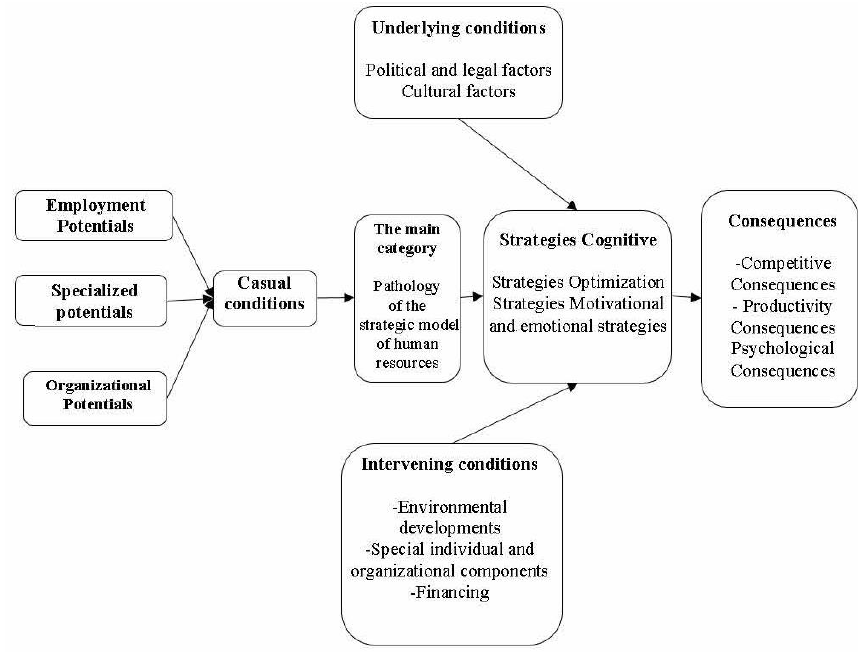
Figure 1- Proposed research model of Pathology of the strategic model of human resources based on digital transformation